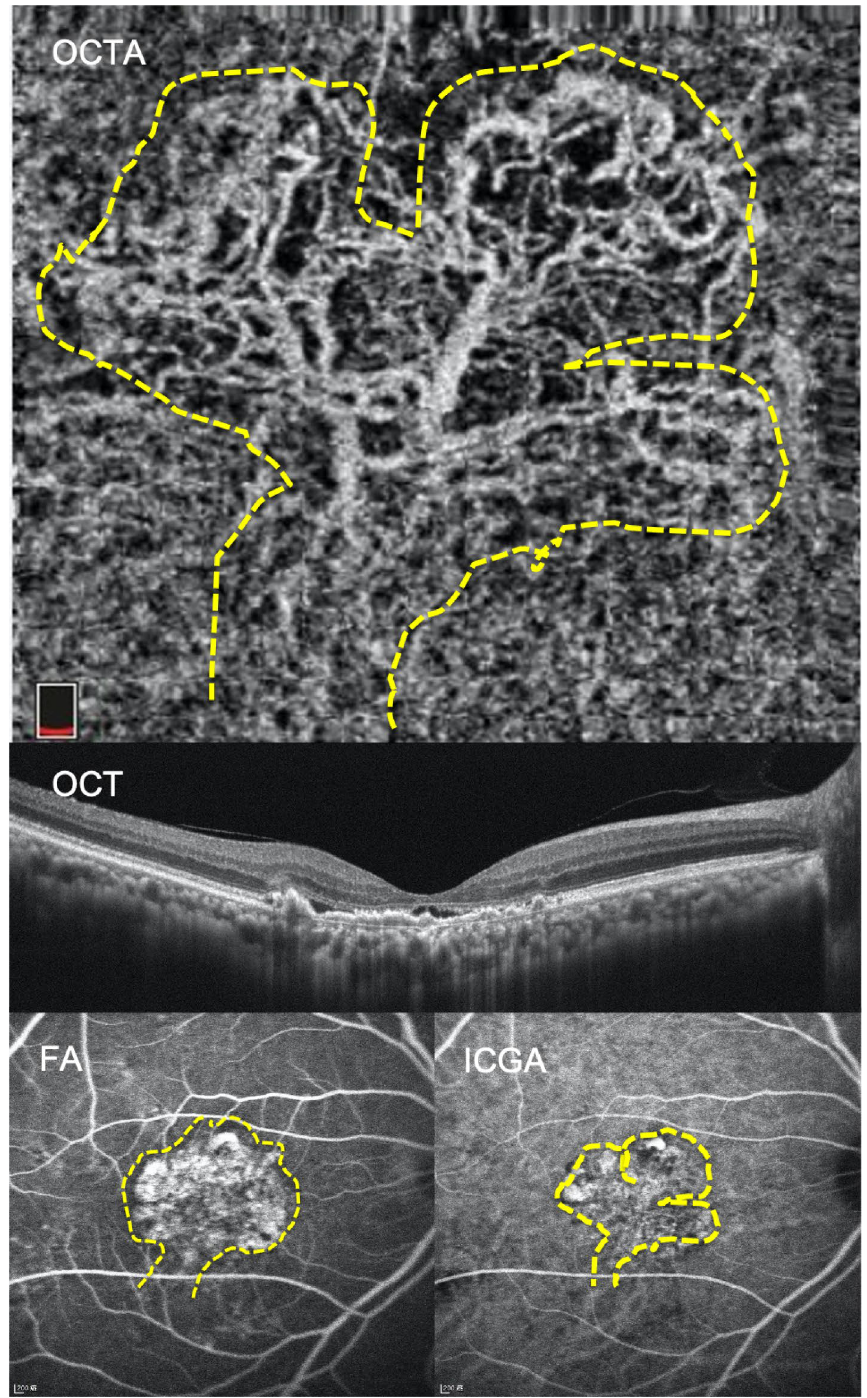
Figure 1. The branching vascular network (BVN) morphology revealed through optical coherence tomography angiography (OCTA) had significant correlation with polypoidal choroidal vasculopathy (PCV) characteristics revealed through indocyanine green angiography (ICGA) and fluorescent angiography (FA). A 72-year-old female patient had type 1 BVN and type C PCV in the right eye. Baseline best corrected visual acuity was 20/800. The OCTA image showed major vascular trunk with further branching of BVN (trunk form, highlighted by dashed line). The subfoveal choroidal thickness was 200 μm. ICGA showed a cluster of polypoid lesions and BVN with a definite feeding origin; obvious leakage was also detected through FA. Multiple drusenoid deposits and retinal pigment epithelial detachment existed. BVN branching vascular network, PCV polypoidal choroidal vasculopathy, BCVA best-corrected visual acuity, OCTA optical coherence tomography angiography, OCT optical coherence tomography, FA fluorescent angiography, ICGA indocyanine green